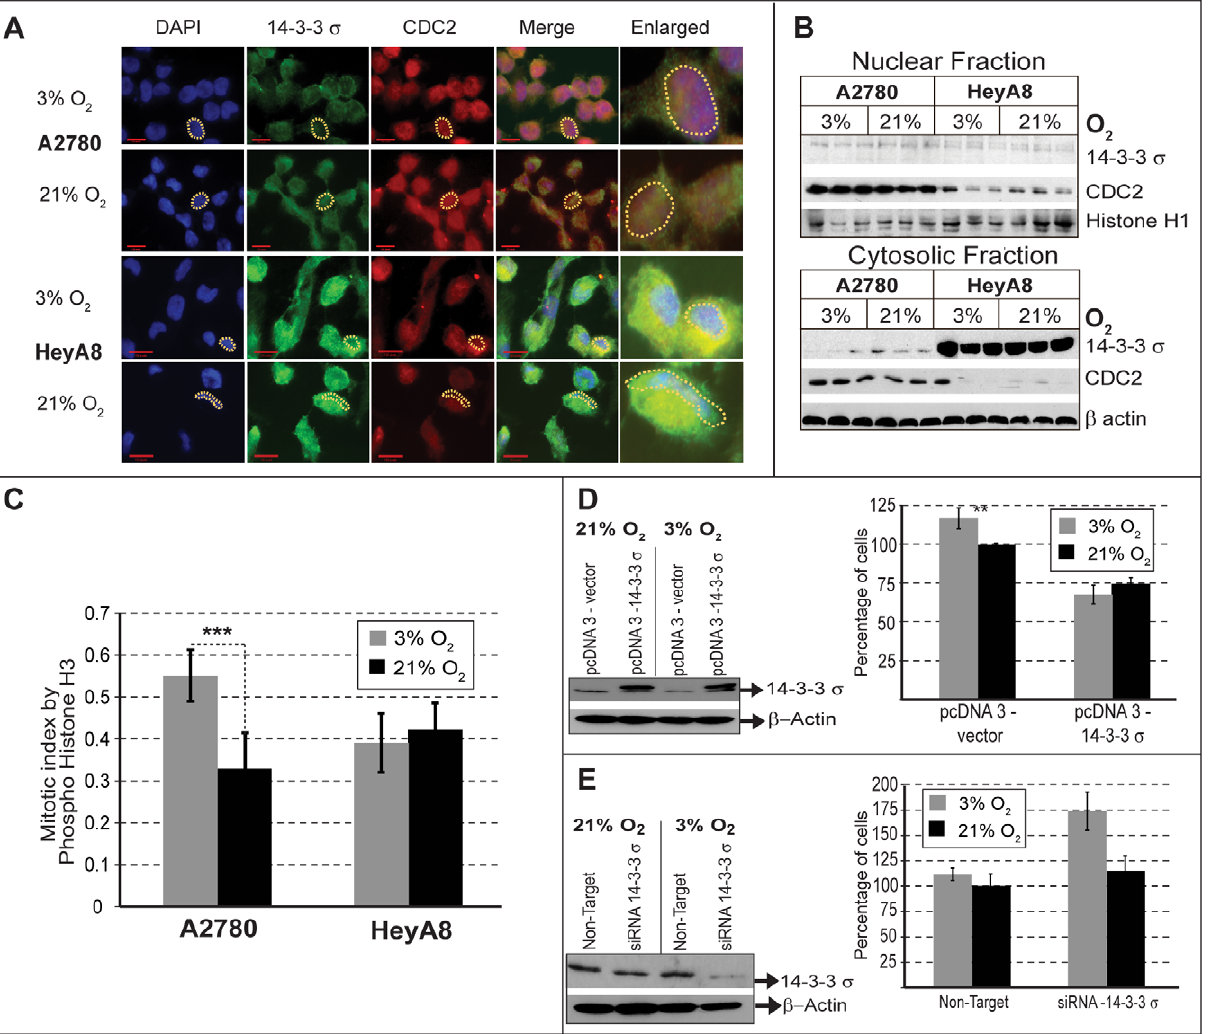
Figure 5. 14-3-3 s and O 2 sensitivity. (A) Cellular localization by immunofluoresence shows that 14-3-3 s (Green) is located in the cytoplasm and CDC2 (Red) is present in the nucleus (Blue). Compared to O 2 sensitive A2780 cells, the level of 14-3-3 s is higher and CDC2 is low in the O 2 insensitive HeyA8 cells. In the O 2 sensitive A2780, 14-3-3 s is localized both in the nucleus and cytoplasm at 21% O 2 . (A dotted yellow line, outlines a representative nuclei to indicate relative localization of 14-3-3 s and CDC2 in these cells). (B) Western blot analysis of nuclear and cytoplasmic fractions show low levels of 14-3-3 s in the nucleus compared to cytoplasm, with increased amounts of 14-3-3 s being present in the cytoplasm of the O 2 insensitive HeyA8 cells. The level of CDC2 is higher both in the nucleus and cytoplasm of the O 2 sensitive A2780, but present in lower amount only in the nucleus of O 2 insensitive HeyA8 cells. Histone H1 and b 2 actin were used as loading controls for nuclear and cytoplasmic fractions, respectively. (C) Mitotic cells were determined by counting the cells that stained positively for a mitosis specific marker, Phospho-Histone H3 from the total cell population. Mitotic fractions present at 3% or 21% O 2 were counted in both A2780 and HeyA8 and represented as bar graph. A significant increase in mitotic index (p . 0.001, indicated by asterisk) was observed in the O 2 sensitive A2780 at 3% O 2 , but not in the O 2 insensitive HeyA8 cells. (D) Over-expression of 14-3-3 s in the O 2 sensitive A2780 (Western Blot) results in loss of O 2 sensitivity (Bar graph). For the cells transfected with empty vector (mock transfection) or 14-3-3 s over-expression construct, the percent of cell proliferation was compared with proliferation of mock transfected cells grown under standard tissue culture conditions consisting of 21% O 2 (ambient), and (E) in the converse experiment performed with O 2 insensitive HeyA8, reducing the levels of 14-3-3 s by siRNA (Western blot) results in restoration of O 2 sensitivity (Bar graph). For the cells transfected with scrambled siRNA (mock transfection) or siRNA against 14-3-3 s , the percent of cell proliferation was compared with proliferation of mock transfected cells grown under standard tissue culture conditions consisting of 21% O 2.